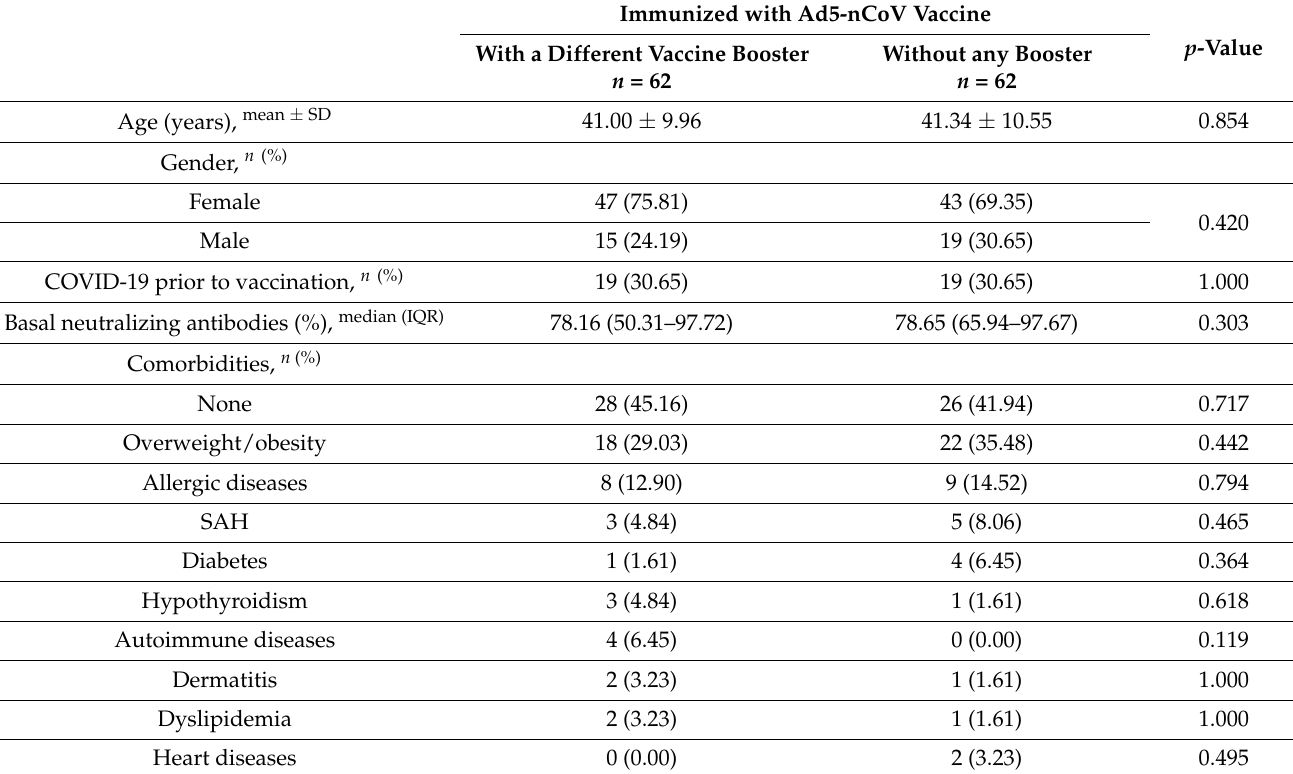
Table 1. Clinical and demographic characteristics of the study groups. Immunized with Ad5-nCoV